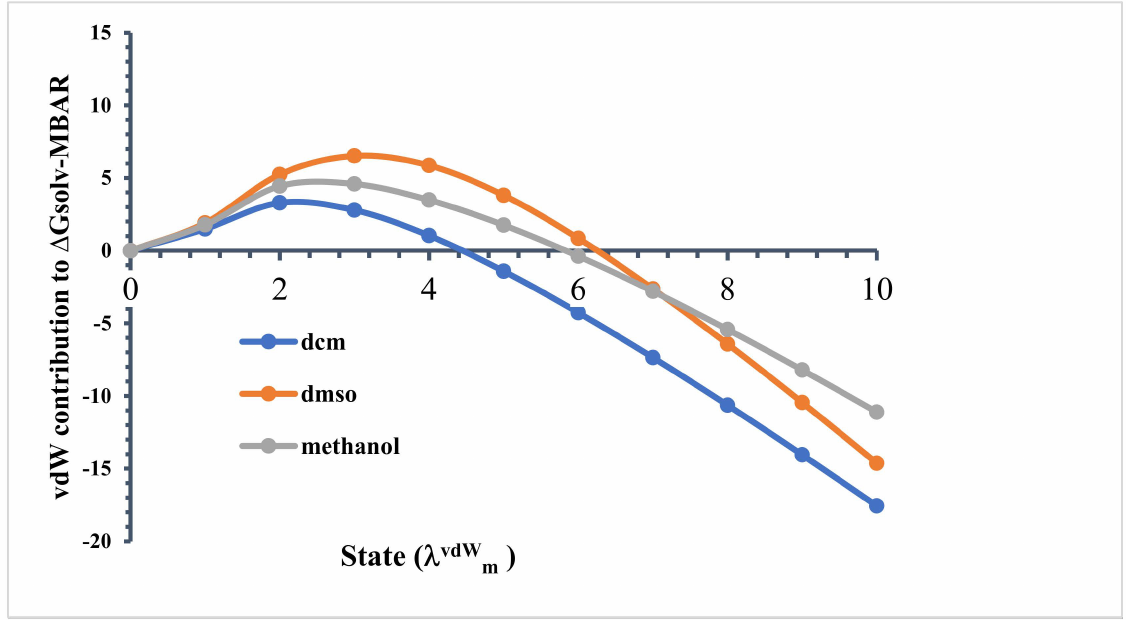
Figure 9. Contribution of the van der Waals force at each stage of the ∆ G solv calculation using Multistate Bennett acceptance ratio